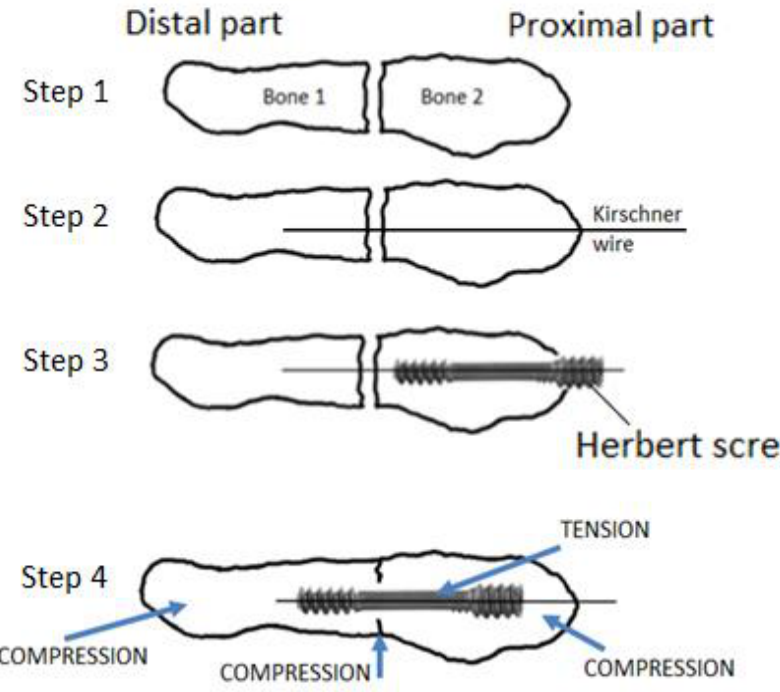
Figure 4. Procedure of the Herbert screw insertion.